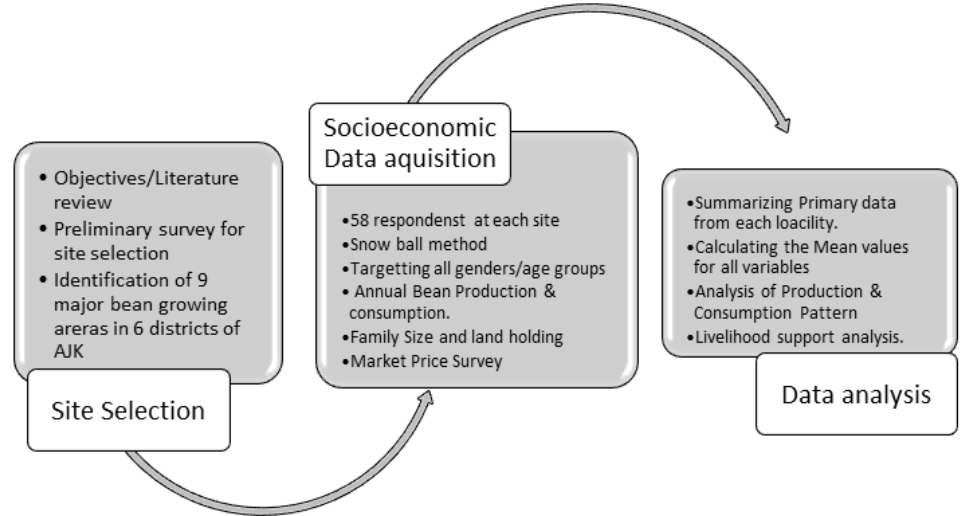
Figure 6. Flow chart of the sampling methodology employed for the collection of socioeconomic data in the bean producing areas of the AJK region.